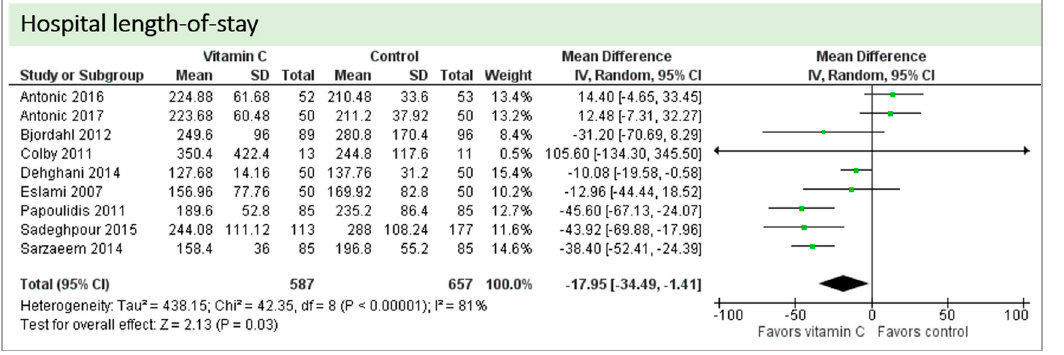
Figure 9. Hospital length of stay.